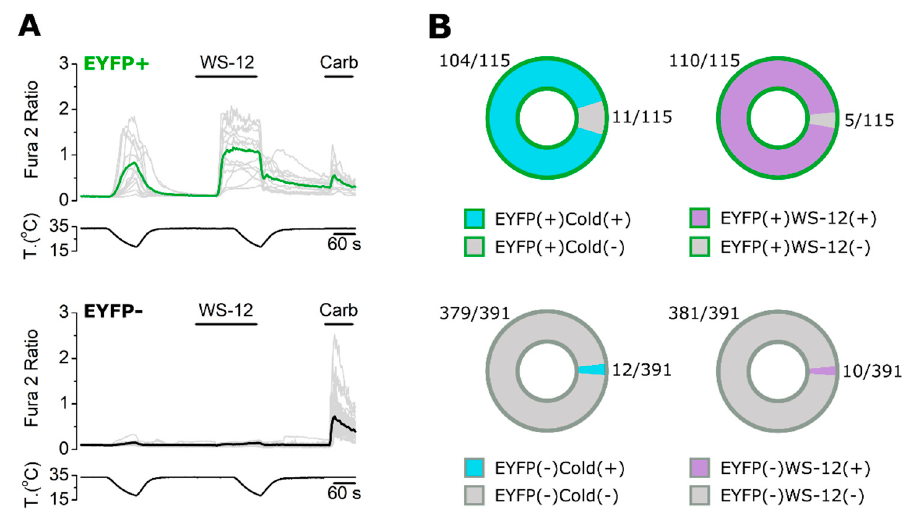
Figure 1. Calcium imaging in HEK-293 cells transiently overexpressing mTRPM8-EYFP. ( A ) Repre- sentative traces of calcium transients evoked by mild cold ( ∼ 18–20 ◦ C), WS-12 (10 µ M) and Carbachol (50 µ M) in both EYFP+ and EYFP − cells. Traces corresponding to individual cells are shown in grey. Colored traces represent averages of the respective individual traces. ( B ) Proportion of EYFP+ and EYFP − cells responding to cold and WS-12. n = 506 cells; 2 independent experiments.